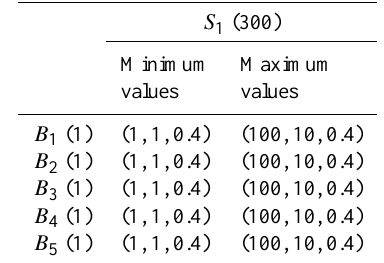
Table 4. Characteristics of initial litter chemistry for the data in litterbag decomposition field studies in Wisconsin (WI) and Mas- sachusetts (MA). The table is organized based on Table 3 in Moor- head and Sinsabaugh (2006), who obtained data from Aber et Table 2. Parameter ranges for microbial model S1B5. The param- al. (1984) and Magill et al. (1998). The final LCI is model predicted (cid:16) (cid:17) K S ,ij ,k + ,µ ij eter vectors are presented in the form , whose (see Sect. 3.3.2 for details). We have also extracted time series data ij, 2 from the Magill et al. (1998) study for model assessment (Figs. 15 units are, respectively, mgCdm − 3 , d − 1 , and none. Numbers in the and S1). parentheses following the state variables are their initial values, whose units are mgCdm − 3 . All five microbes used a respiration rate 0.005d − 1 . The maximum and minimum parameter values were Litter type, Labile Holocellu- Lignin specified based on Wang et al. (2012).